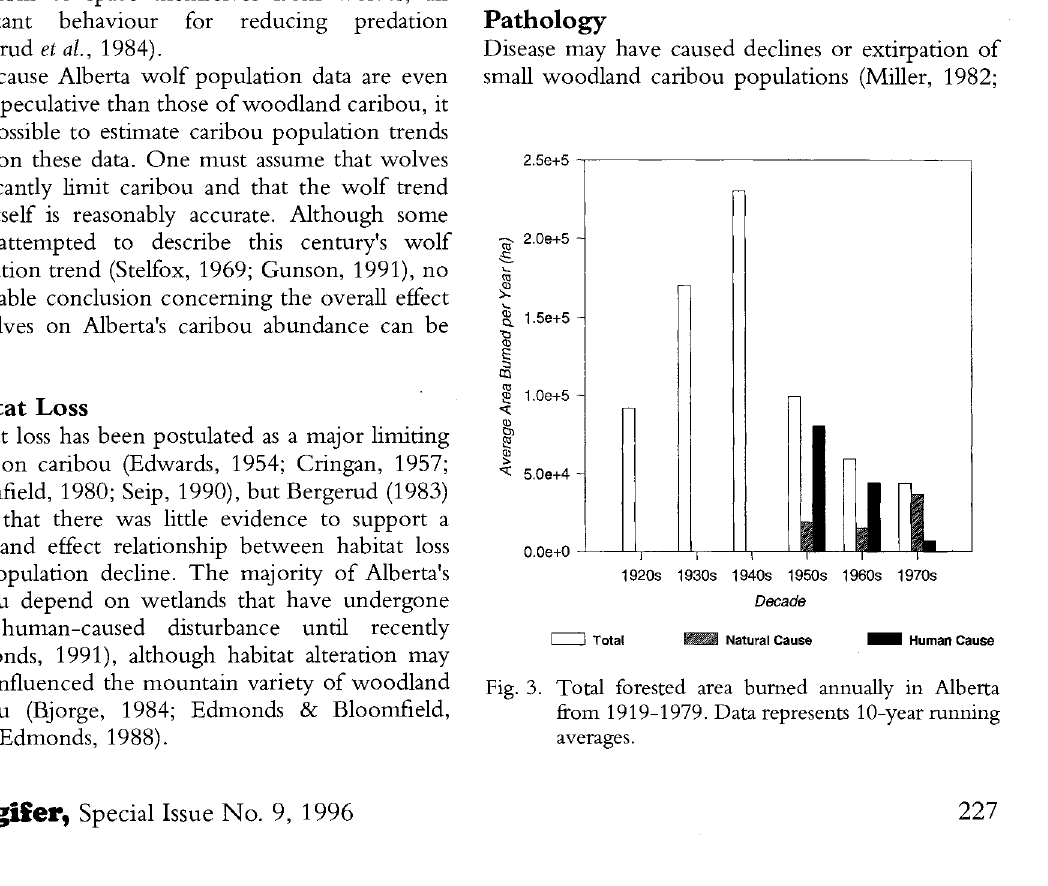
Fig. 2. Yearly human kill of male woodland caribou in Alberta from 1909-1981 and woodland caribou hunting licences sold from 1967-1979. No kill data are available from 1924-1948. Only big game licences required prior to 1967 (Edmonds, 1986).